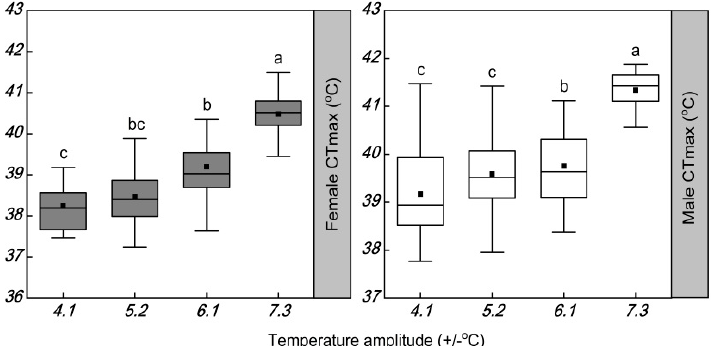
Figure 4. Box plot of the heat coma temperature (CT max ) of females and males of Plutella xylostella developed under four daily temperature amplitudes with a similar mean temperature. The upper and lower boundaries of the box indicate the 75th percentile and 25th percentile of the data set, respectively. The black horizontal line and black square within the box represent the median and mean values, respectively. Error bars above and below the box indicate the minimum and maximum values, respectively. Different letters above each box indicate significant differences ( p < 0.05) among the treatments.